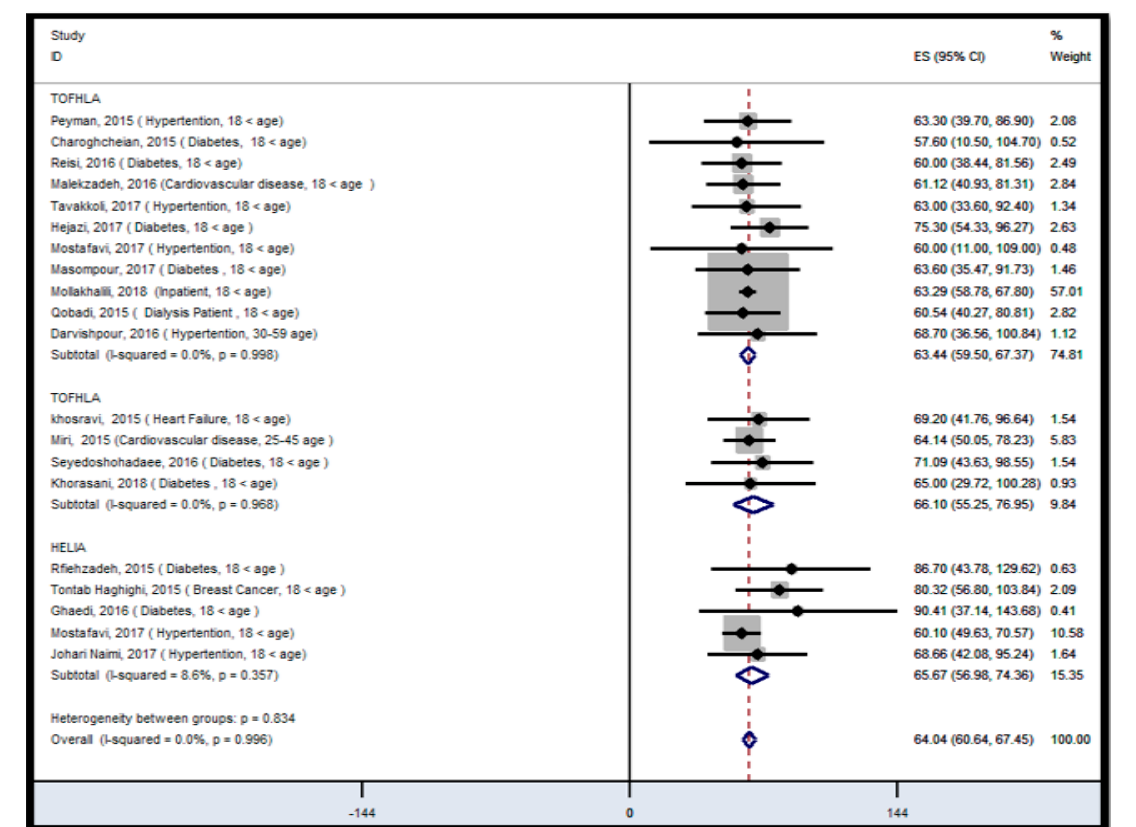
Figure 3. Forest plot of the distribution of effect size for health literacy status from 2012 to 2014, ES: effect size, I 2 : a measure of the ratio of the total variation in study measures due to heterogeneity, p > 0.05: devastates heterogeneity is appropriate for interpretation.